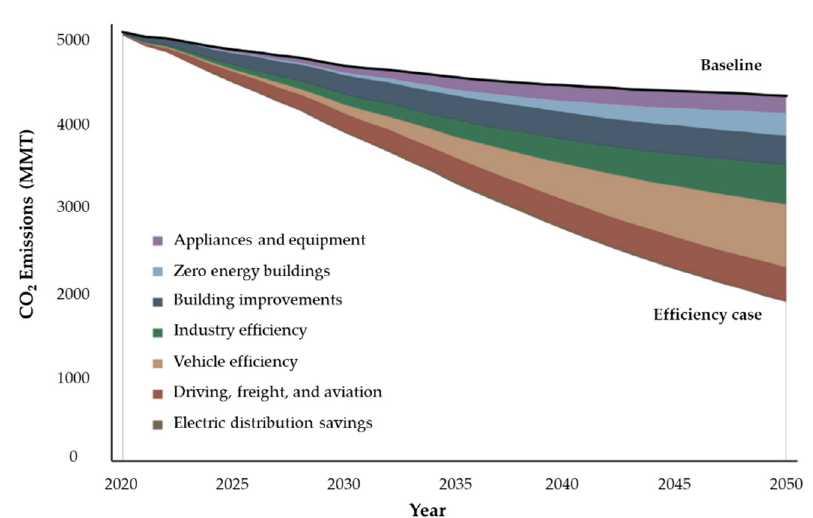
Figure 3. Energy-related carbon dioxide emissions in the reference and efficiency cases. Source: Modified from ACEEE (2019) [84]. Note: MMT means a million metric ton.